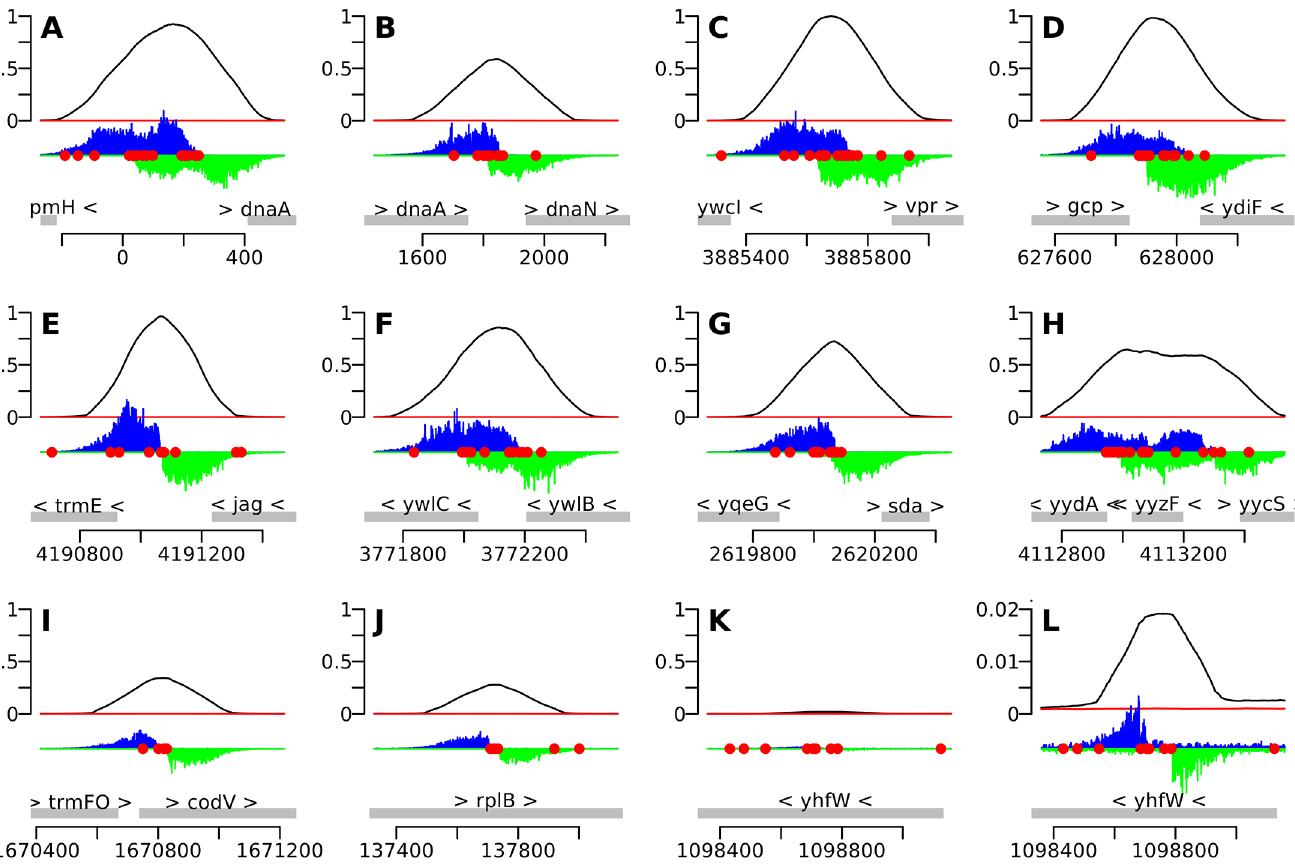
Fig 2. IDAP-Seq data for individual regions bound by DnaA. The 10 strongest binding regions (A-J) , plus one weaker binding region (K , L) , are displayed, using binding data at 1.4 μ M ATP-DnaA-his. The bottom section of each panel shows the genomic coordinates (using the AG1839 genomic sequence), the positions of each gene (gray rectangles), and the gene names. Arrowheads indicate the direction of transcription. The middle section of each panel is a histogram of the number of sequence reads that start at each nucleotide (blue, above the line, for sequence reads mapping to the top strand; green, below the line, for sequence reads mapping to the bottom strand). The red circles indicate DnaA boxes, predicted using the PSSM described in this paper. The top section of each panel is a plot of the amount of DNA recovered (as inferred from the sequence data) versus genome position, using 1.4 μ M ATP-DnaA-his (black line) or no DnaA (red lines). The amount of DNA recovered is scaled to a global maximum of 1, as described for Fig 1. A-J . The 10 strongest binding regions, corresponding to peaks #1 – 10 in Table 1, S1 Table, and S1 Fig. (A) upstream of dnaA (part of oriC ); (B) between dnaA and dnaN , containing the DNA unwinding element (also part of oriC ); (C) upstream of ywcI and vpr ; (D) downstream of gcp and ydiF ; (E) upstream of trmE and downstream of jag ; (F) upstream of ywlC and downstream of ywlB ; (G) upstream of yqeG and sda ; (H) upstream of yydA , spanning yyzF , and upstream of yycS ; (I) within codV ; (J) within rplB . K-L . A representative weaker binding region, (peak #49 in S1 Table; S1 Fig). (K) binding scaled to 1 to be comparable to previous panels; (L) the same region rescaled so that the binding pattern is visible.